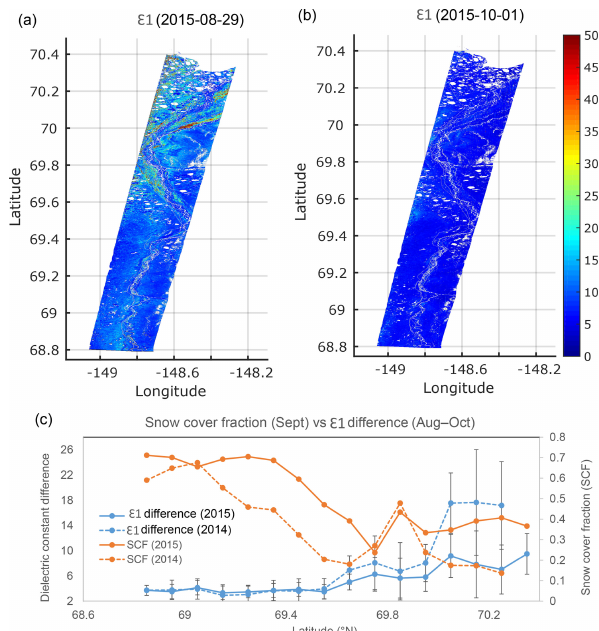
Figure 7. Soil-freezing process indicated by the radar-retrieved (Chen et al., 2019) soil dielectric constant ( ε 1) of surface soils ( ∼ < 0 . 10m) at the DHN transect in August (a) and October (b) , and changes in ε 1 in relation to MODIS SCF (c) . The ε 1 differ- ences between August and October were binned to 0.1 ◦ latitudinal bins, while SCF was calculated as the percentage of snow-covered pixels indicated by MODIS SCE data for each 0.1 ◦ bin. The stan- dard deviations of ε 1 differences for each 0.1 ◦ bin were shown as error